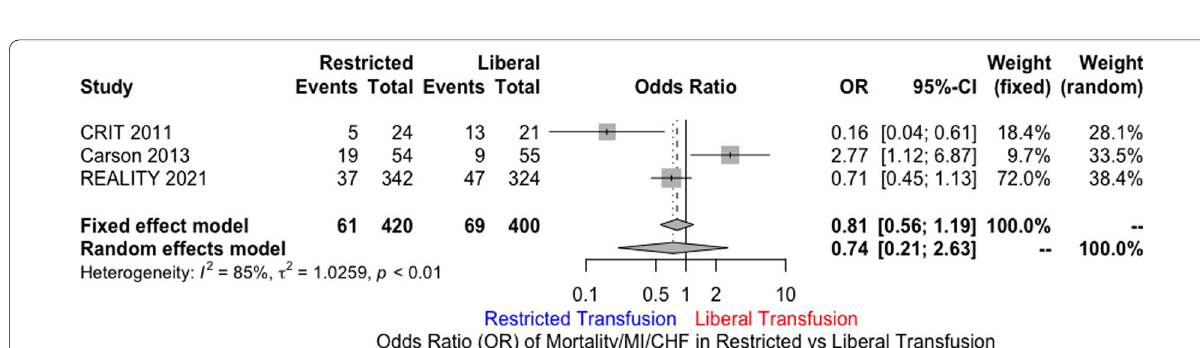
Fig. 2 MACE at 30 days defined as a composite outcome of 30 day all-cause mortality, MI, and CHF. Values present are OR with 95% confidence interval, n , or percentage %. Restricted